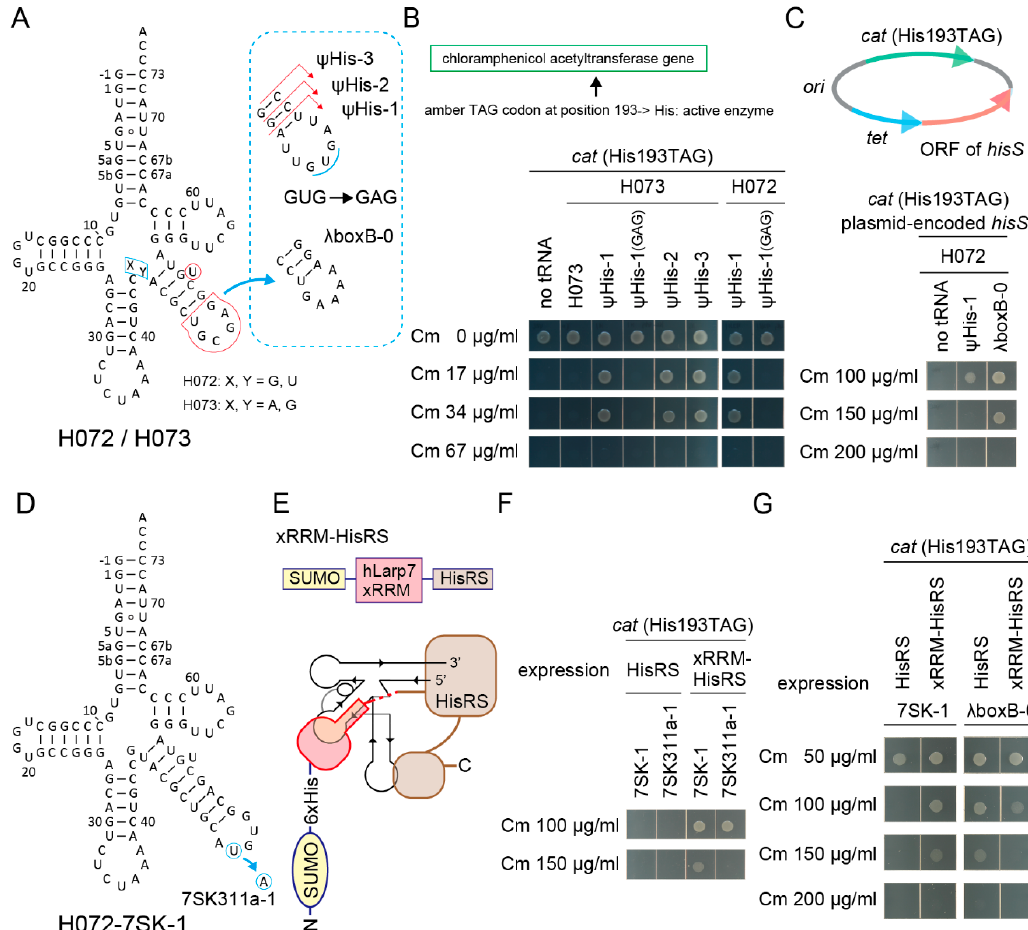
Figure 6. Development of synthetic histidine tRNAs using candidate tRNA chassis and hairpin aptamers. ( A ) The cloverleaf structures of H072 and H073 tRNA variants having an extended V-stem and a modified V-arm loop sequence. ( B ) The H073 ψ His-1/2/3 variants and the H072 ψ His-1 variant conferred up to Cm 34 µg/mL resistance to E. coli DH10B cells expressing the cat(His193TAG) reporter gene. The catalytic His193 residue is essential for the Cm acetyltransferase activity. A point mutation in the V-arm loop sequence (from GUG to GAG) eliminated the His-inserting activity of the ψ His-1 variants. ( C ) The H072 ψ His-1 and λ boxB-0 variants conferred up to Cm 100 µg/mL resistance and 150 µg/mL resistance, respectively, to E. coli DH10B cells expressing the cat(His193TAG) reporter gene and the plasmid-encoded hisS gene ( E. coli HisRS) shown. Note that the agarose plate containing Cm 100 µg/mL was incubated for another four hours to obtain the clear cell spot for H072 ψ His-1. ( D ) The cloverleaf structure of the H072-7SK-1 variant having a 7SK SL4 hairpin. ( E ) A chimeric E. coli HisRS variant fused with the xRRM domain of human Larp7. A binding model of H072-7SK-1 and this xRRM-HisRS is shown. The dashed line indicates linker residues SSGSNSNSGS. ( F ) Expression of this xRRM-HisRS enhanced the His-inserting activities by the H072-7SK-1 and H072-7SK311a-1 variants. The H072-7SK-1 variant conferred up to 150 µg/mL resistance to E. coli DH10B cells expressing the cat(His193TAG) reporter gene and xRRM-HisRS. It was reported that the 7SK RNA SL4 binds the hLarp7 xRRM domain, while the 311a variant binds the xRRM domain more tightly. ( G ) The His-inserting activity of H072-7SK-1 was enhanced by xRRM-HisRS, while that of H072- λ boxB-0 was not enhanced.